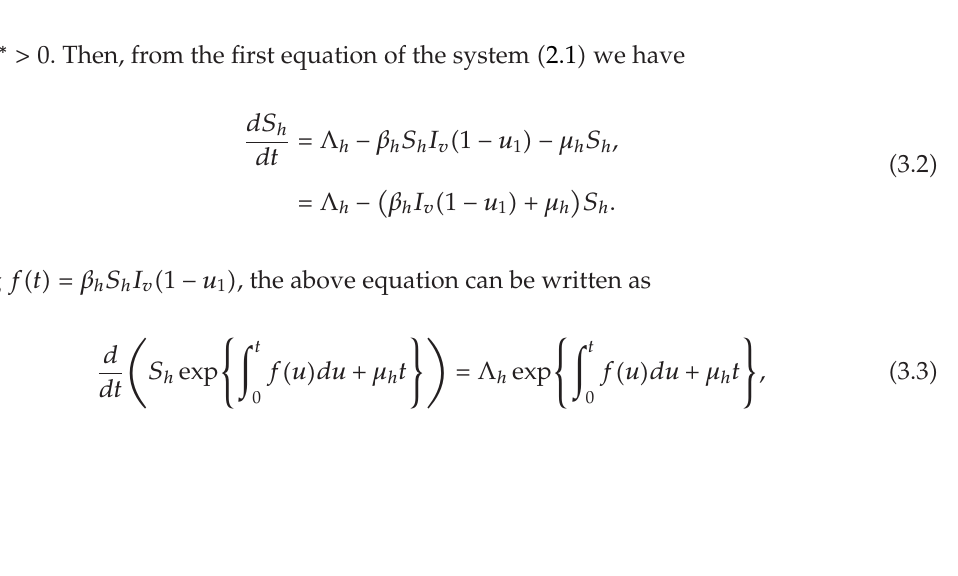
Figure 1: The plot represents population of susceptible, exposed, infected and recovered human both with control and without